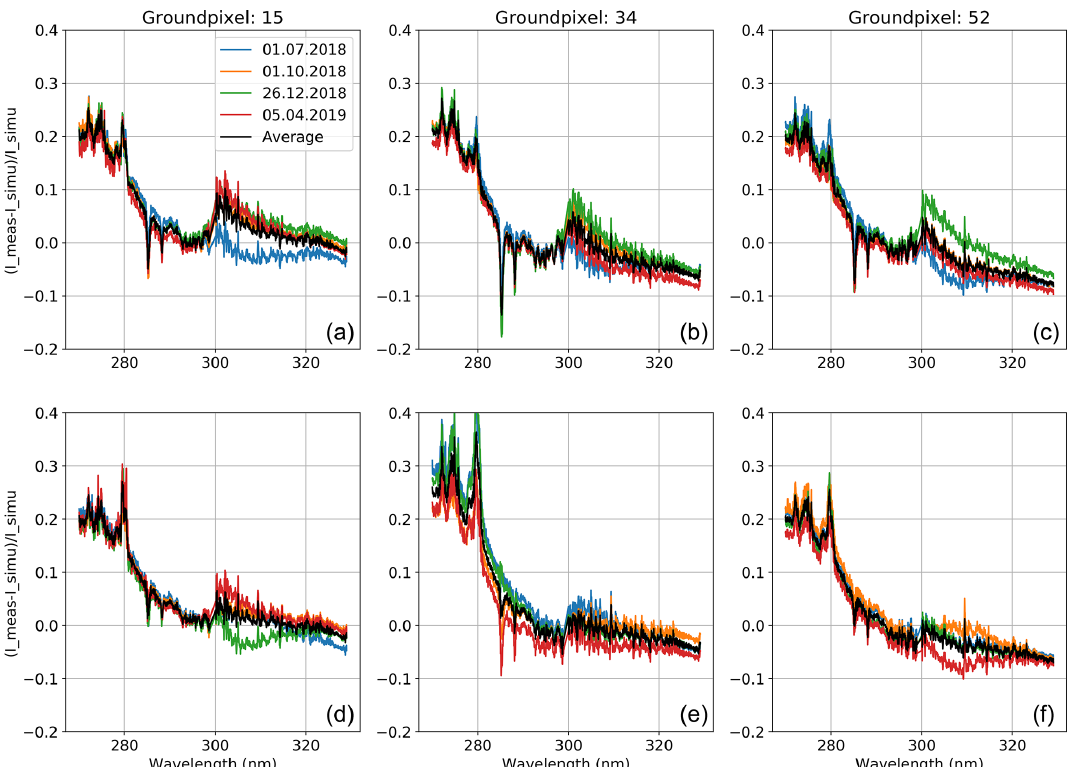
Figure 5. Relative differences between the measured and simulated radiances for three detector pixels (viewing angles). (a, b, c) Cloud-free tropical pixels ( − 20 to 20 ◦ latitude). (d, e, f) Cloud-free extratropical pixels ( − 50 to − 30 ◦ and 30 to 50 ◦ latitude). Black curves represent mean values of four